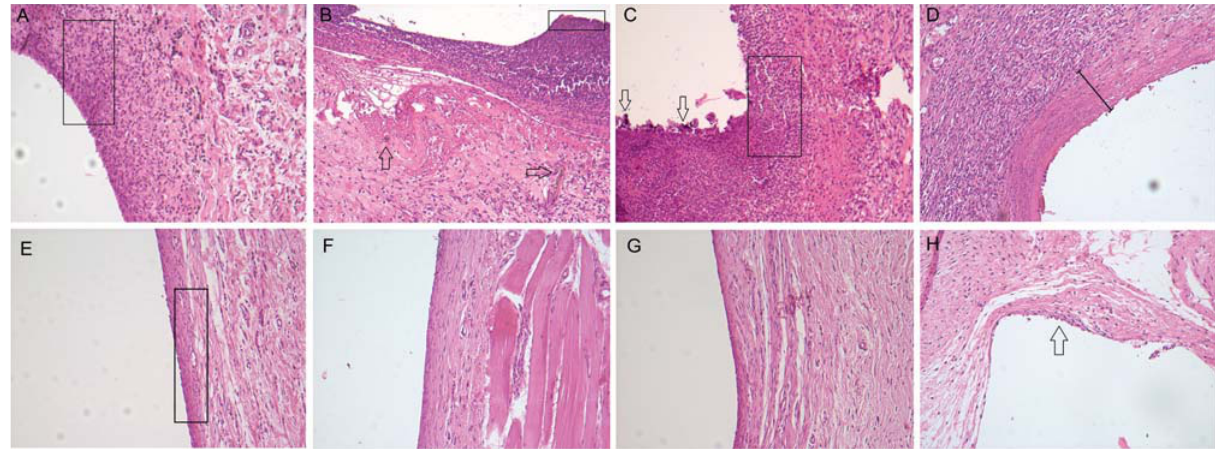
Figure 1- Photomicrographs of histological sections (5 μ m) of subcutaneous tissue stained with hematoxylin & eosin. (A) EBBO 7 d: We